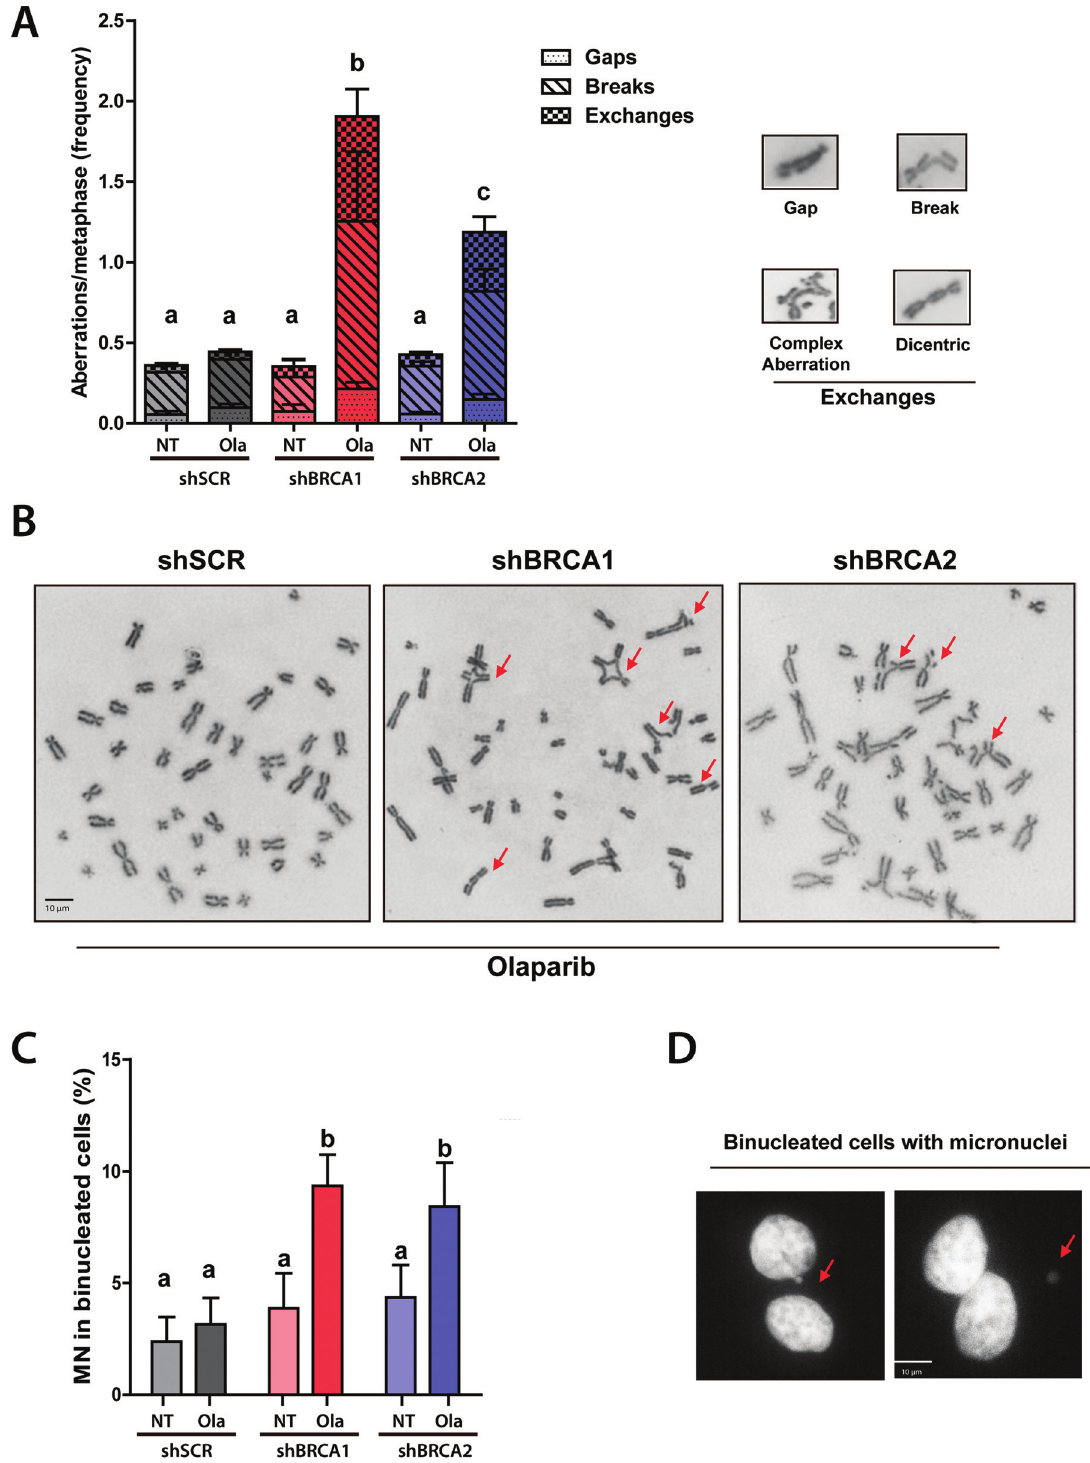
Figure 3 - Chromosome instability precedes Olaparib-triggered cell death in BRCA-deficient HCT116 p21-/- . A) HCT116 p21-/- cells transduced with shSCR, shBRCA1 and shBRCA2 were submitted to cytogenetic analysis 48 h after the treatment with Olaparib. The frequency of gaps, breaks, and ex- changes was calculated after analyzing a minimum of 70 metaphases per condition in 5 independent experiments. B) Representative images of chromosomic aberrations quantified in A. C) HCT116 p21-/- transduced with shSCR, shBRCA1 and shBRCA2 were treated for 24 h with Olaparib and were arrested at a binucleated stage using cytochalasin B. The frequency of micronuclei was estimated (shown as mean (cid:6) SD, using DAPI staining and fluorescence microscopy (magnification: 100X), analyzing a minimum of 300 binucleated cells per condition in 4 independent experiments. D) Repre- sentative images of chromosomic aberrations quantified in C. Statistical analysis was performed using two-way ANOVA with Bonferroni post-hoc test and differences were considered significant with p (cid:7) 0.001. The letters above the different values indicate groups that are significantly